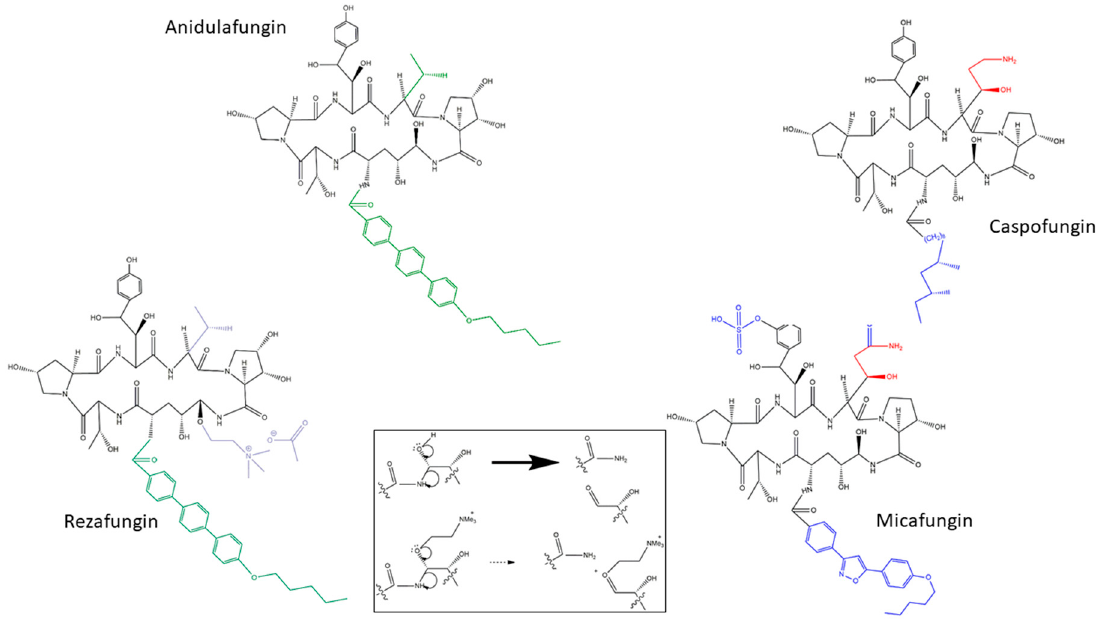
Figure 1. Chemical structure of FDA-approved echinocandins (anidulafungin, caspofungin, and micafungin) and rezafungin. In black, the common chemical structure of the four molecules. In red